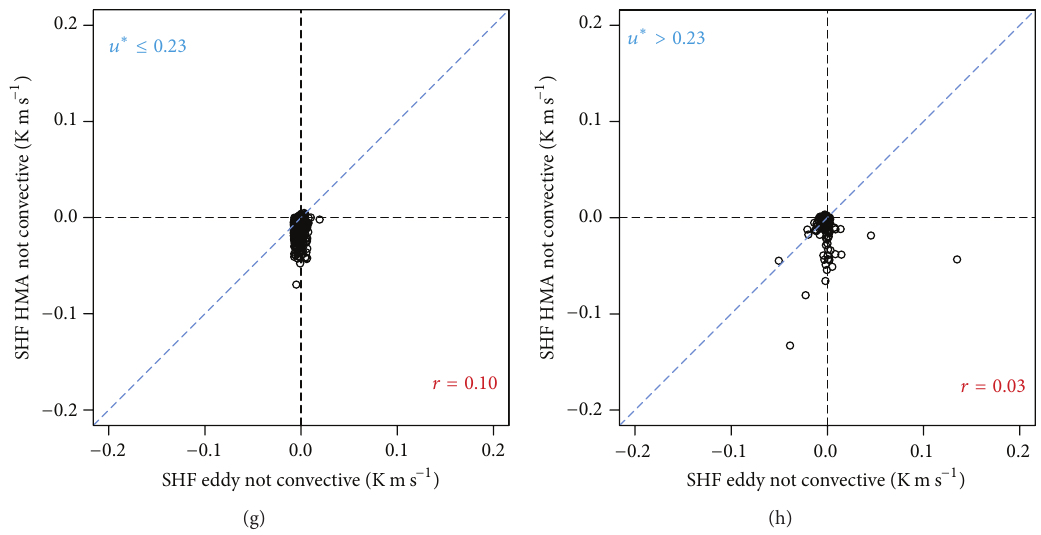
Figure 3: 30 min averages of the kinematic sensible heat flux (Kms −1 ), eddy covariance versus HMA. Additionally shown is the correlation coefficient between the two data series and the linear regression (line and equation) for data from the convective period: (a) for the time window 16.6. to 31.8. and friction velocities ≤ 0.23 ms −1 , (b) for the time window 16.6. to 31.8. and friction velocities > 0.23 ms −1 , (c) Figure 3(a) for quality flags 1–3, (d) Figure 3(b) for quality flags 1–3, (e) for the time window 1.9. to 15.6. and friction velocities ≤ 0.23 ms −1 , (f) for the time window 1.9. to 15.6. and friction velocities > 0.23 m s −1 , (g) Figure 3(e) for quality flags 1–3, and (h) Figure 3(f) for quality flags 1–3.